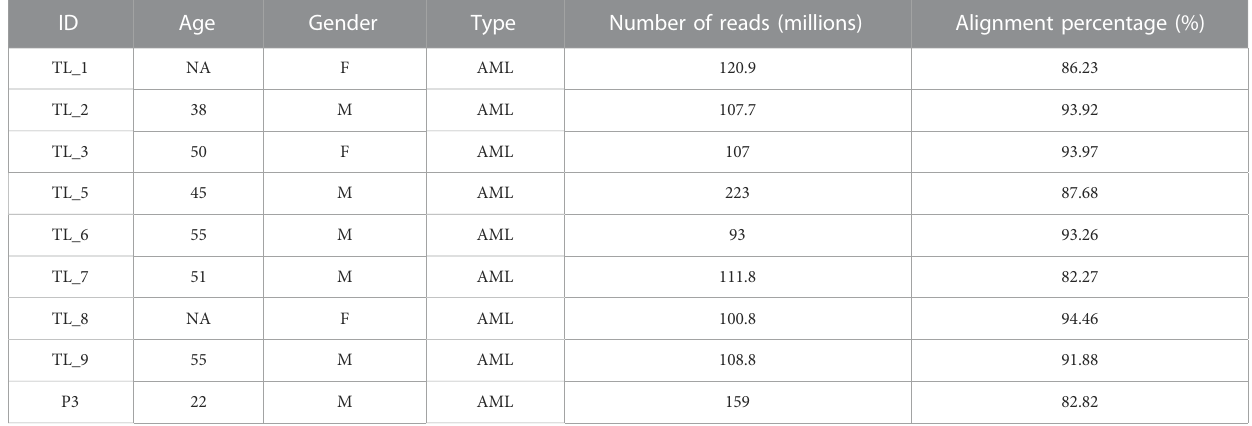
TABLE 1 Patient details and alignment statistics of the 10 Acute Leukemia